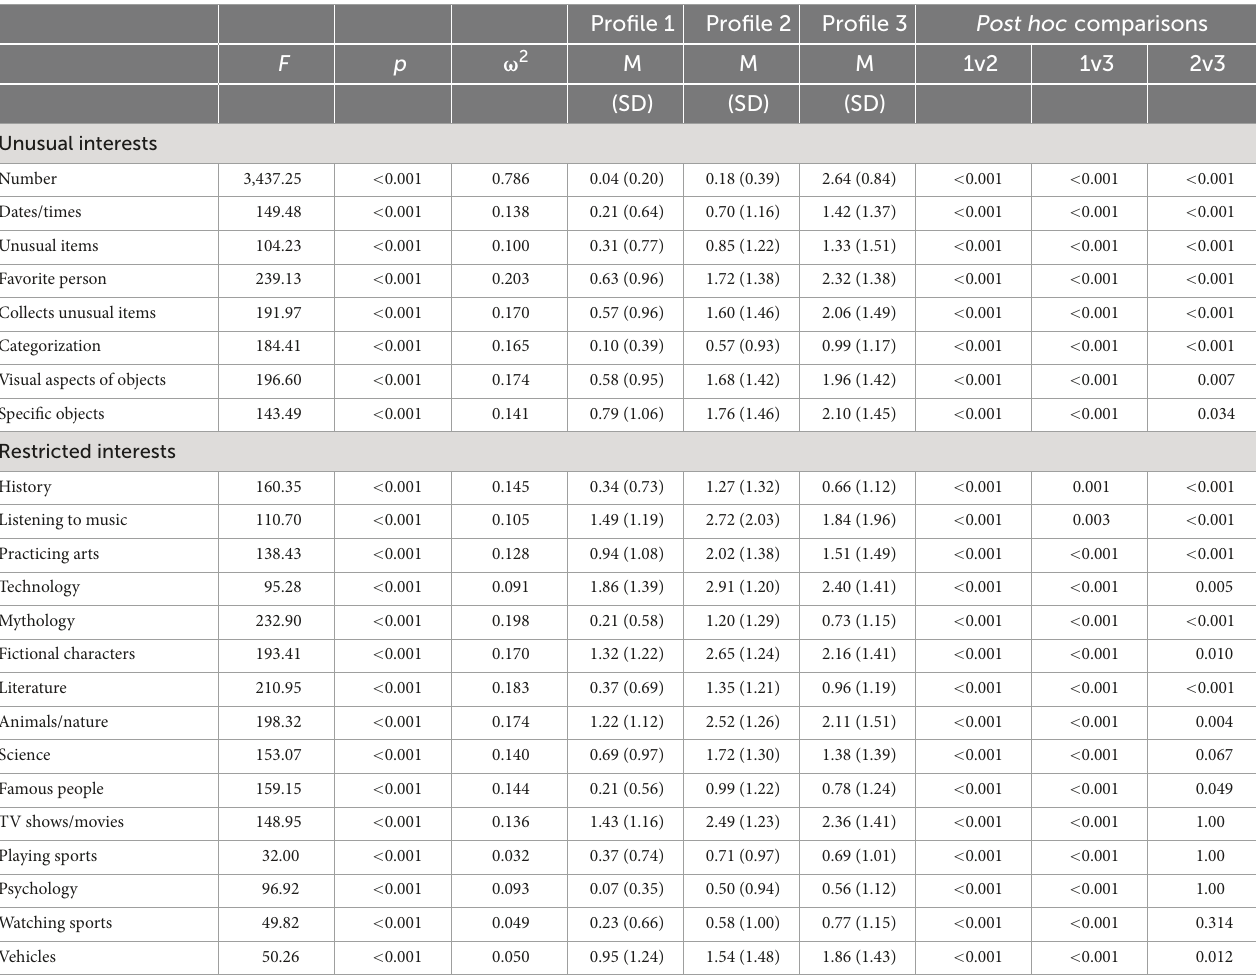
TABLE 3 LPA profile differences on RI and UI